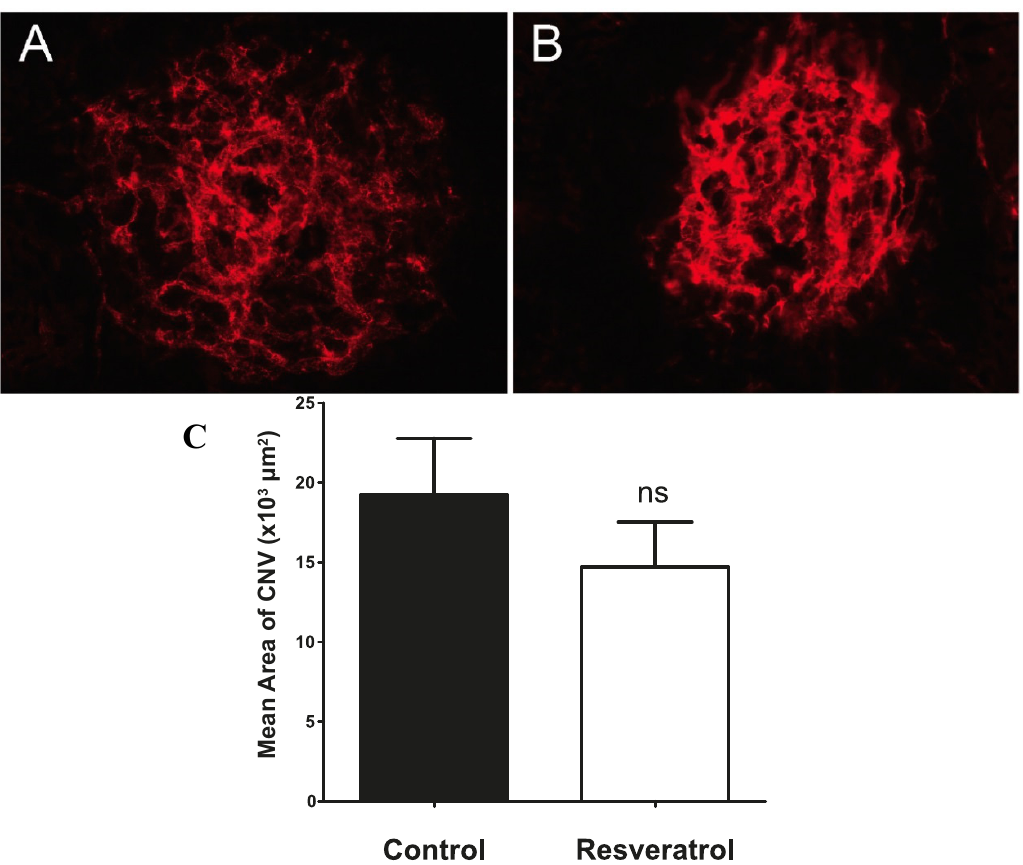
Figure 5. Continuous release of lower levels of resveratrol does not affect new blood vessel formation in a mouse model of CNV. Representative sclerochoroidal flat mounts from mice receiving vehicle ( A ) or resveratrol ( B ) via slow release osmotic pumps. Treatment began five days prior to the induction of CNV and continued for a total